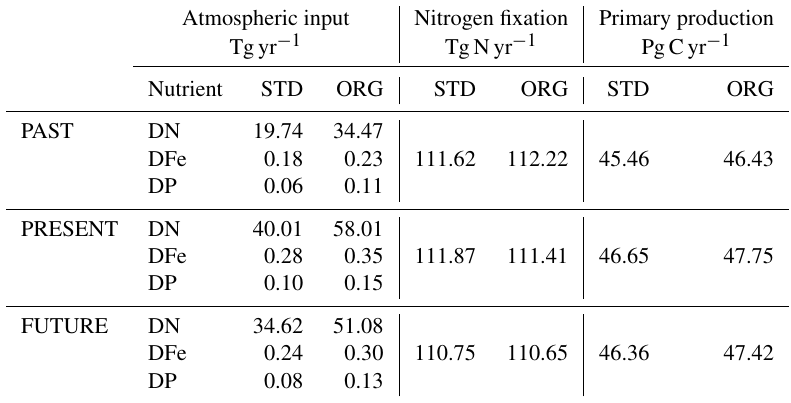
Table 1. Nutrients’ (N, Fe, P) atmospheric inputs (Tgyr − 1 ) considered in PISCES, nitrogen fixation (TgNyr − 1 ), and primary production (PgCyr − 1 ) as calculated by the STD and ORG simulations for PAST (1851–1870 average), PRESENT (2001–2020 average), and FUTURE (2081–2100